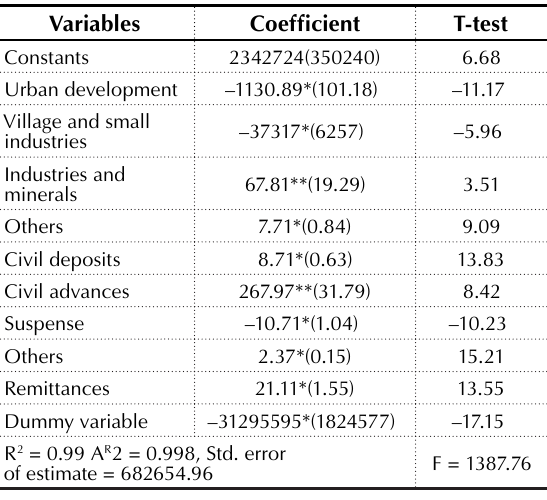
Table 11. Regression results for capital receipts